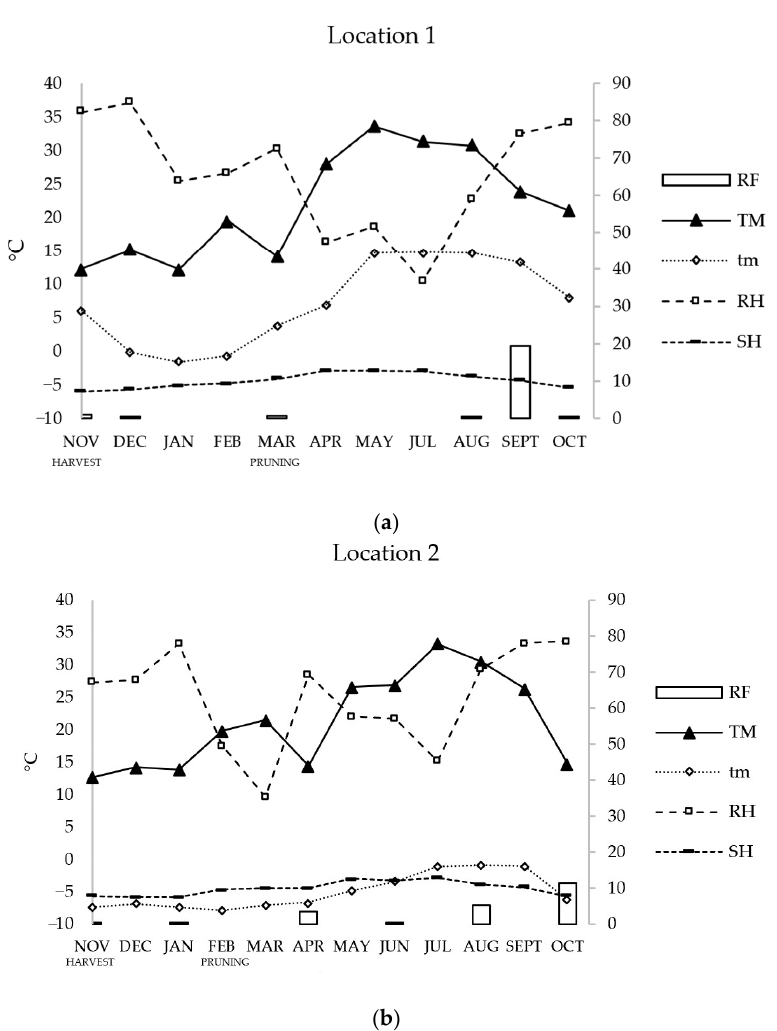
Figure 1. Climatic conditions from November (2019) to October (2020). ( a ): Location 1; ( b ): Location 2. Main axis: absolute maximum temperature (TM; ◦ C) and absolute minimum temperature (tm; ◦ C). Secondary axis: rainfall (RF; mm), relative humidity (RH; %) and sunshine hours (SH;